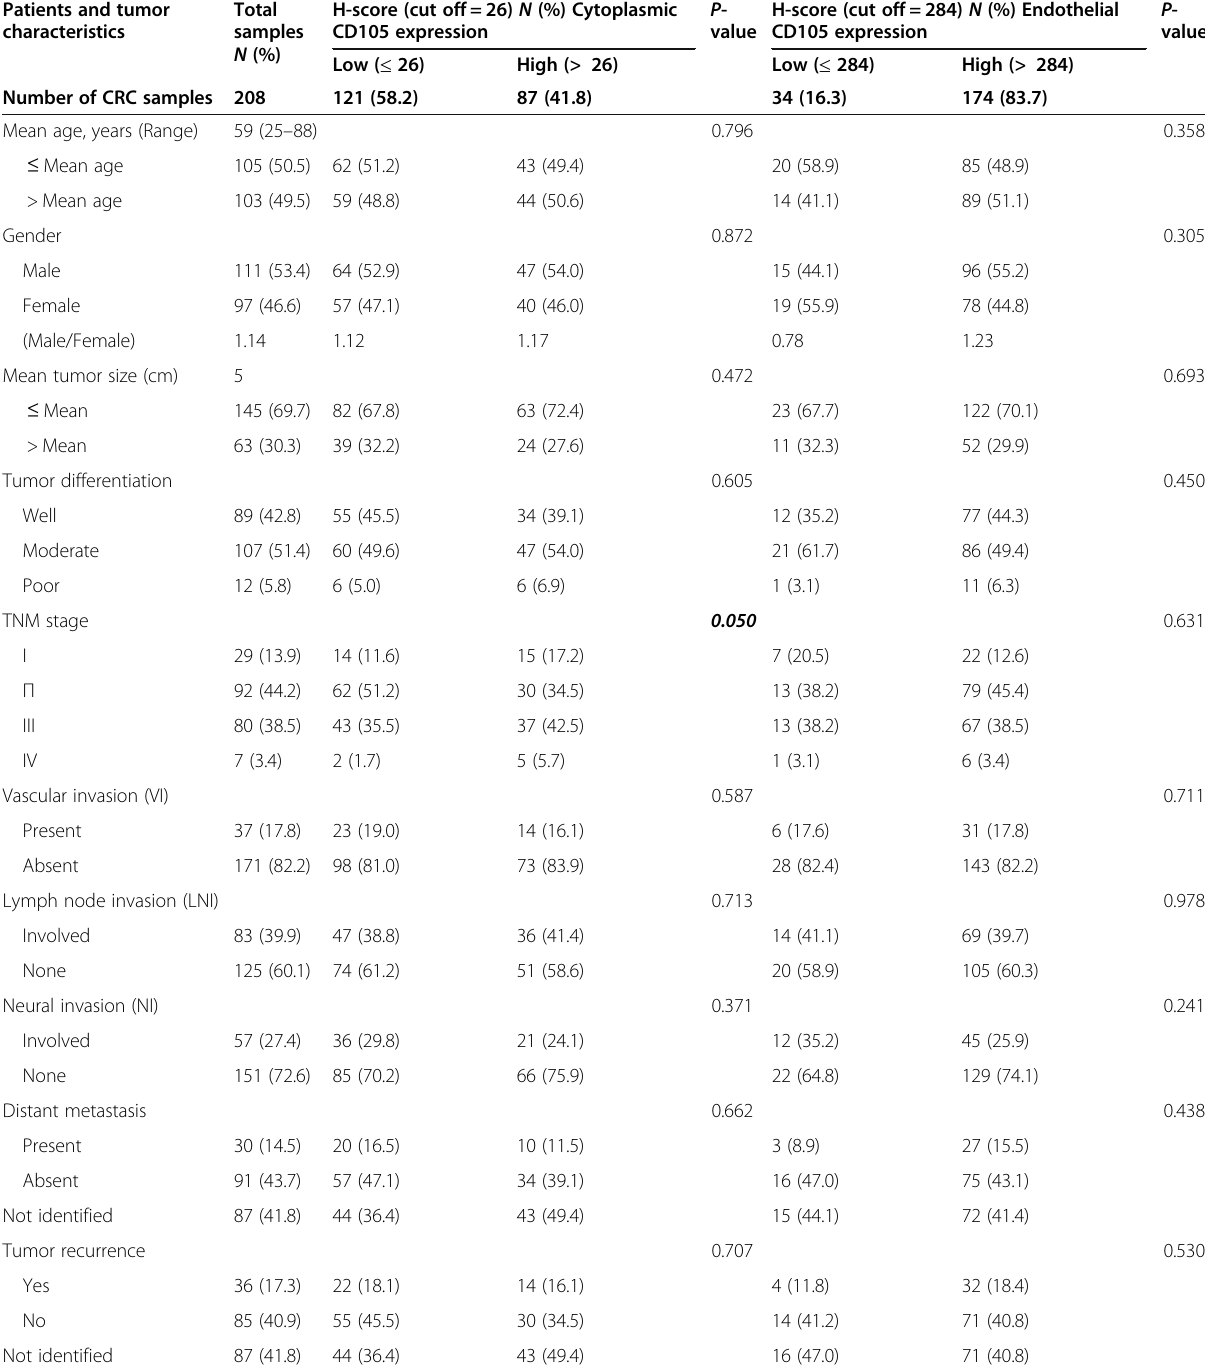
Table 4 The association between cytoplasmic and endothelial CD105 expressions and clinicopathological parameters of colorectal cancer (CRC) samples (H-score) ( P value; Pearson ’ s χ 2 test) Patients and tumor